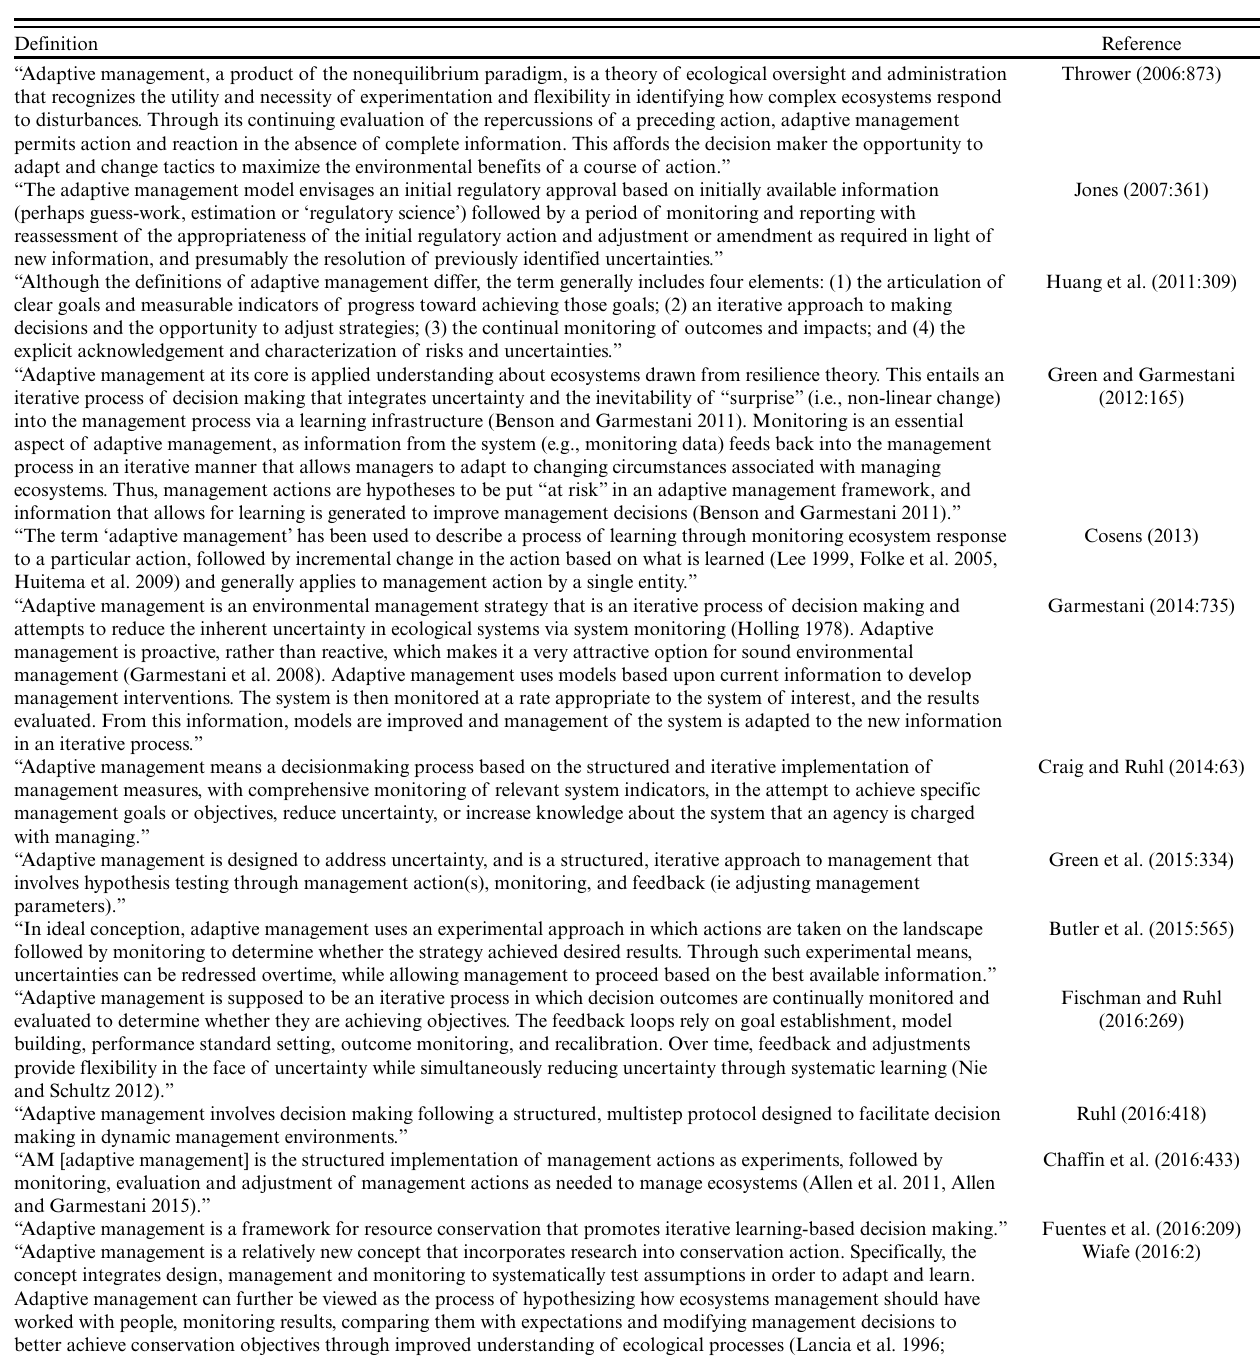
Table 2 . Selected definitions of adaptive management extracted from the literature